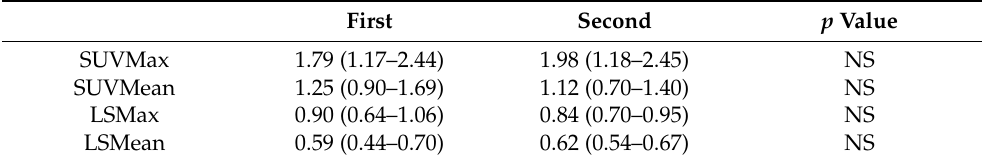
Table 3. Averaged 18F-NaF deposits on skin.